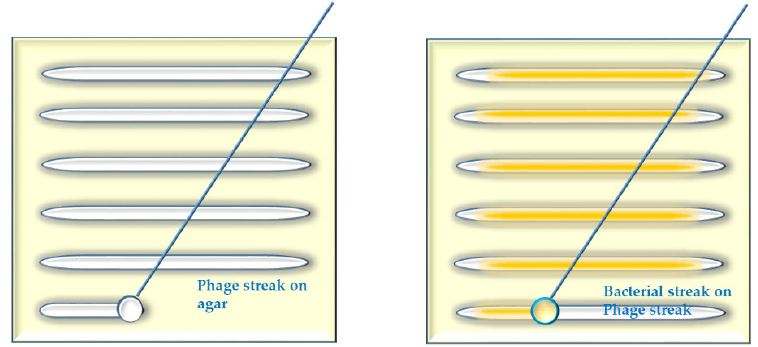
Figure A4. Diagram depicting the “ streak on streak” method.